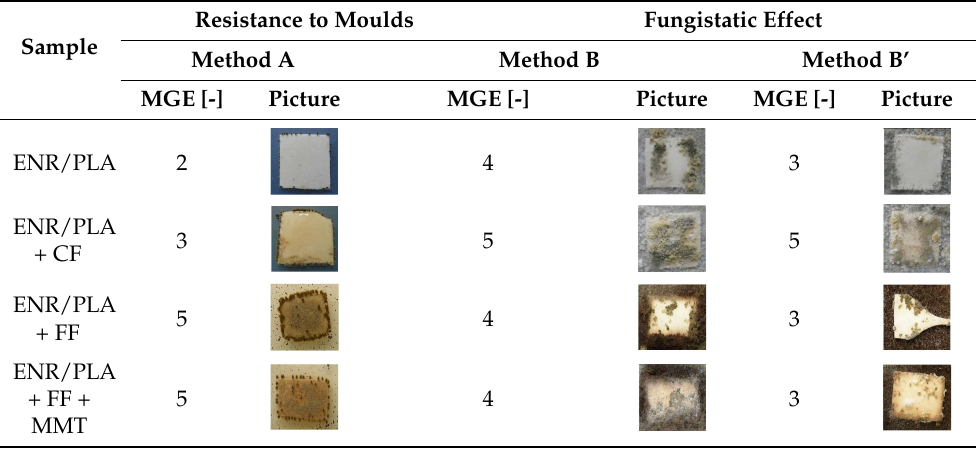
Table 5. The effect of molds on the unaged ENR/PLA blends; MGE—microorganism’s growth evalua-